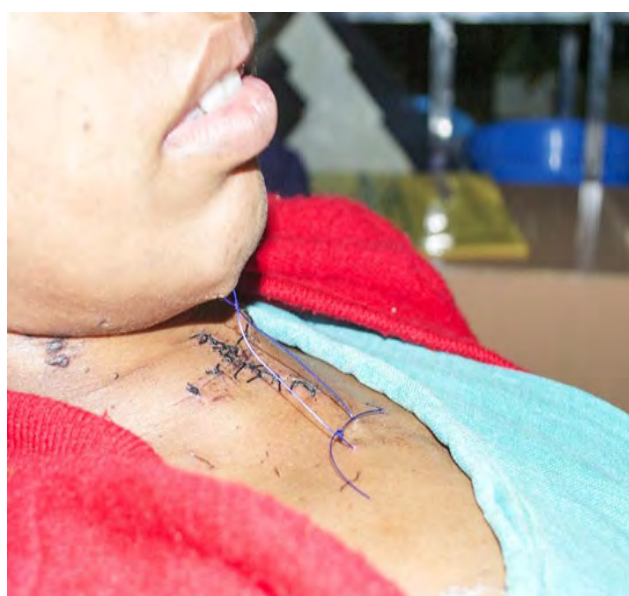
Fig 5: Mento - Sternal